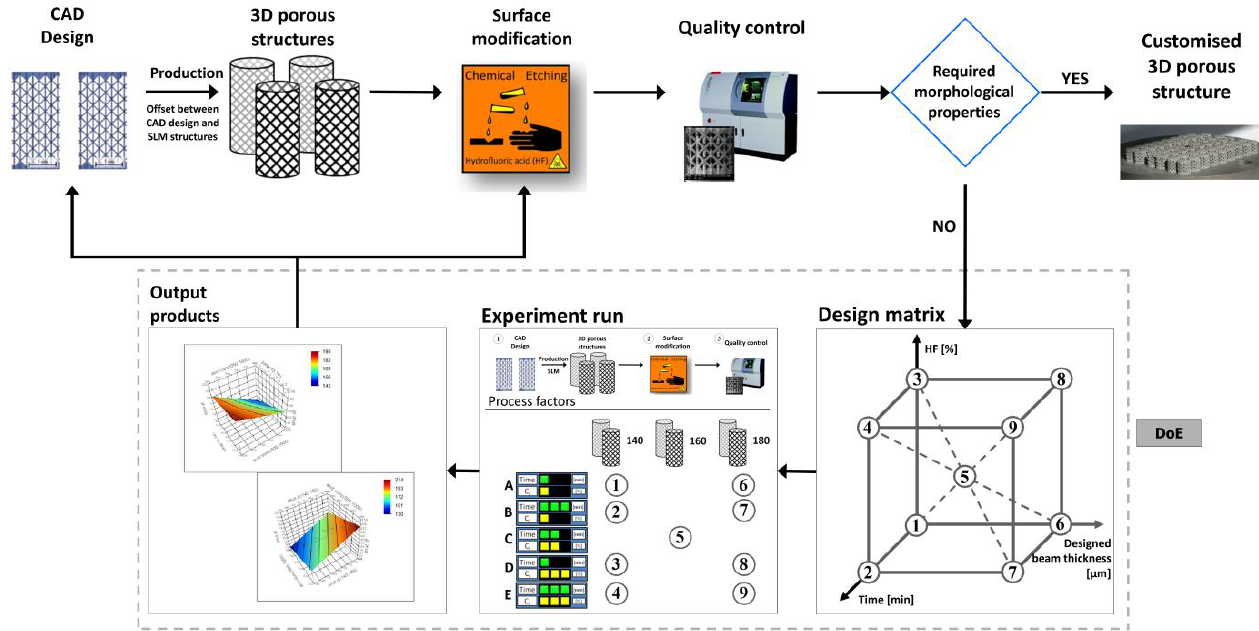
Figure 6. A schematic overview of the proposed production and surface treatment process for customized SLM-Ti6Al4V structures supported by the design of experiments (DoE)